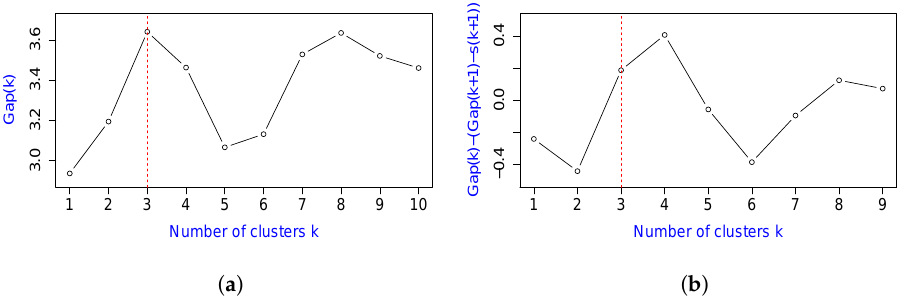
Figure 3. ( a ) Gap statistics in terms of the corresponding number of clusters and ( b ) results of choosing the optimal number of clusters.